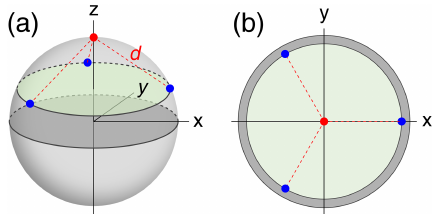
Figure 1. Example tagging geometry for three sites. The nu- clear position of interest is located at the red dot, with the tag- ging sites located at the blue dots, equidistant about the circum- ference of the green disc. d denotes the distance of the nuclear spin from the paramagnetic centres. (a) View of the parameters used in a 3-dimensional representation. (b) View along the z axis onto the 2-dimensional cross-section containing the tagging